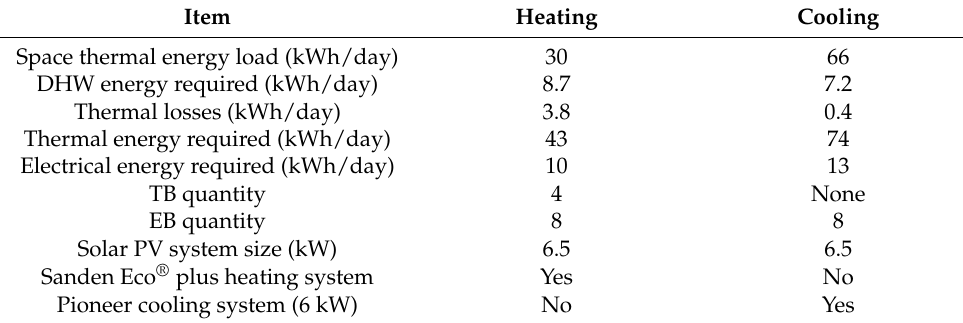
Table 4. System requirements for design heating and cooling loads. Energies are per